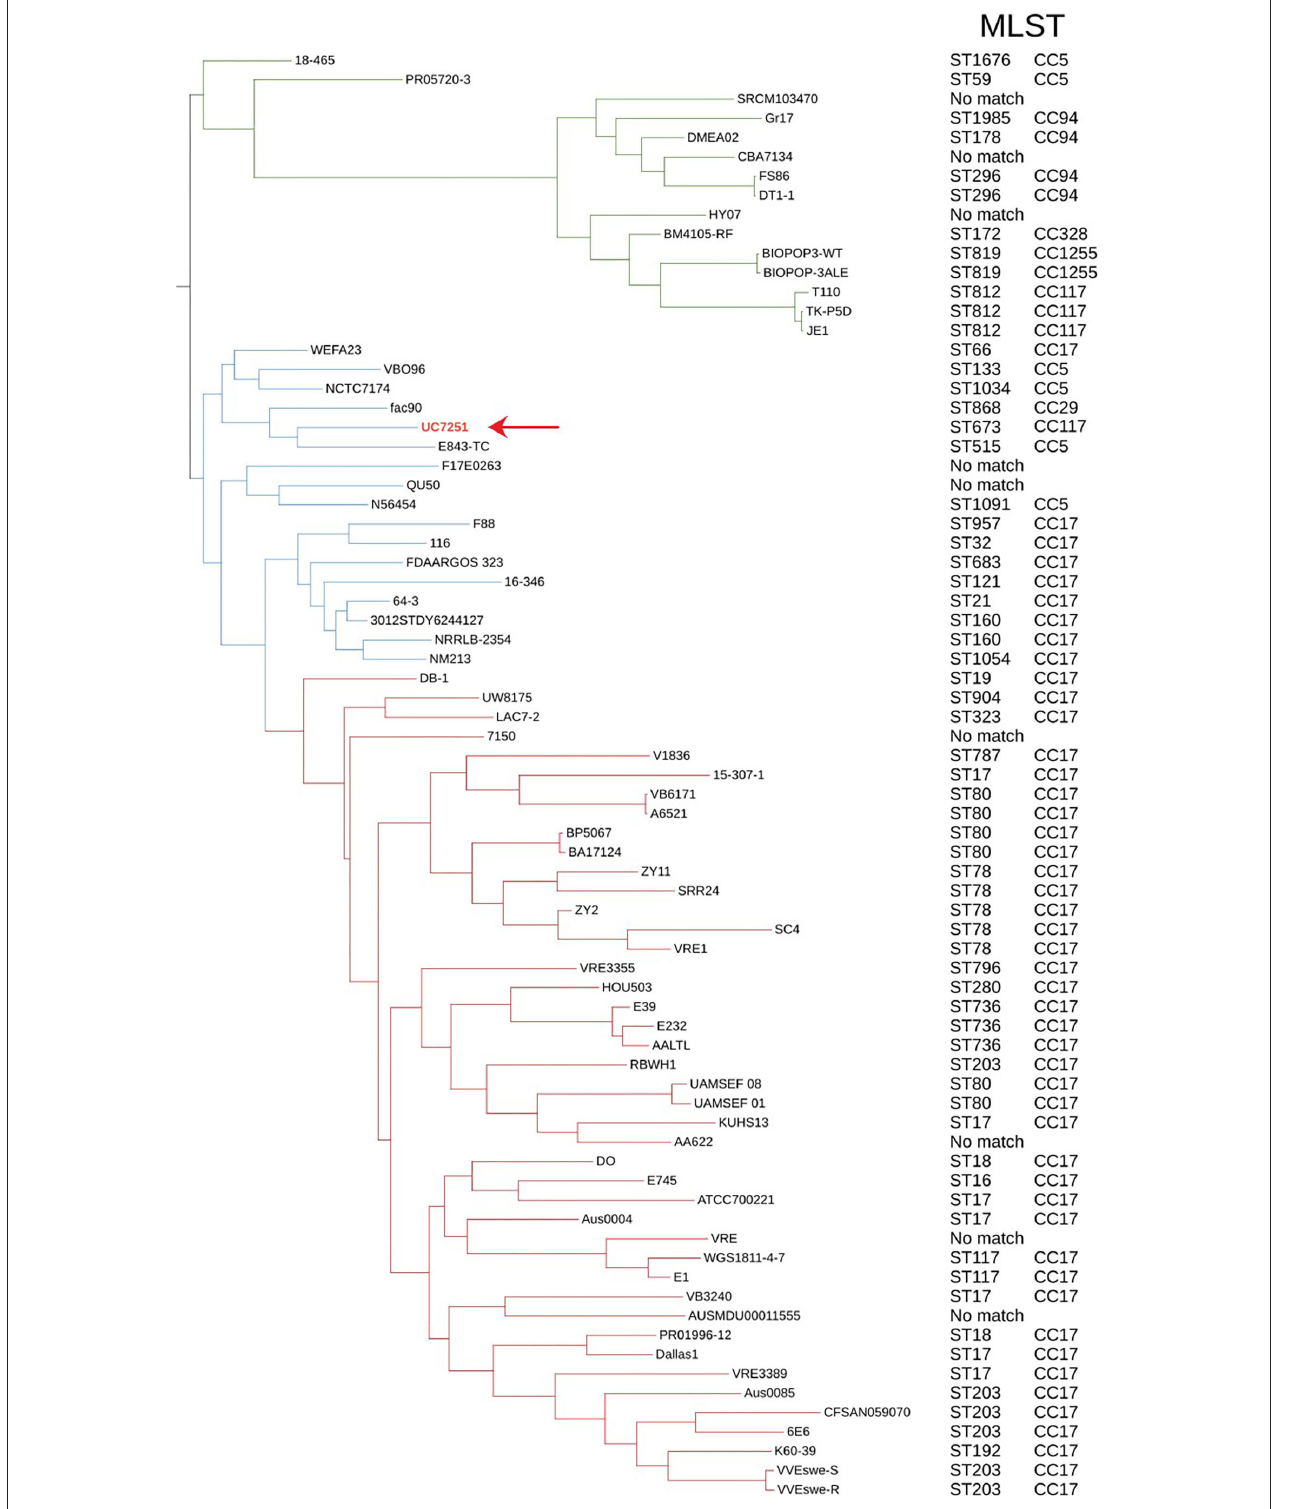
FIGURE 1 | Maximum likelihood phylogenetic tree constructed using the core genome alignment of the selected 75 genomes and respective MLST and clonal complexes. E. faecium clade A1 strains are marked with red branches, clade A2 strains marked with blue, and clade B strains with green. Strain UC7251 (pointing arrow and text in red) is grouped among clade A2 isolates and belongs to ST673 part of CC117.